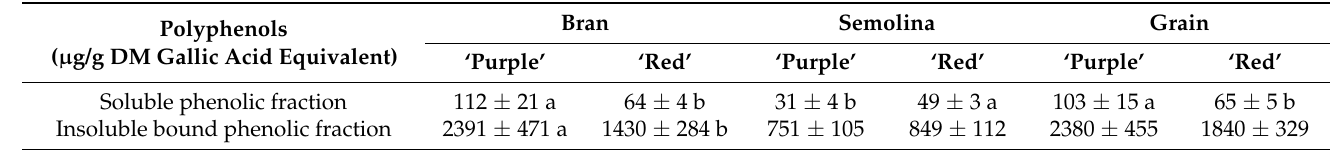
Table 2. Soluble and insoluble polyphenolic fraction in ‘Purple’ and ‘Red’ landraces. Values are reported as mean ± SD ( n = 5). Significant differences between the two varieties for bran, semolina, or grain are indicated by lowercase letters ( t -test, p < 0.05).